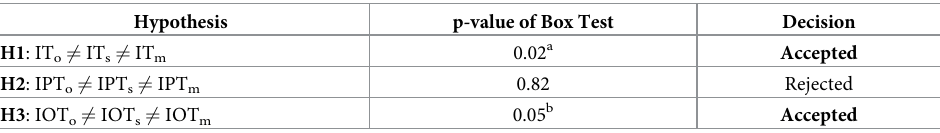
Table 16. Hypotheses